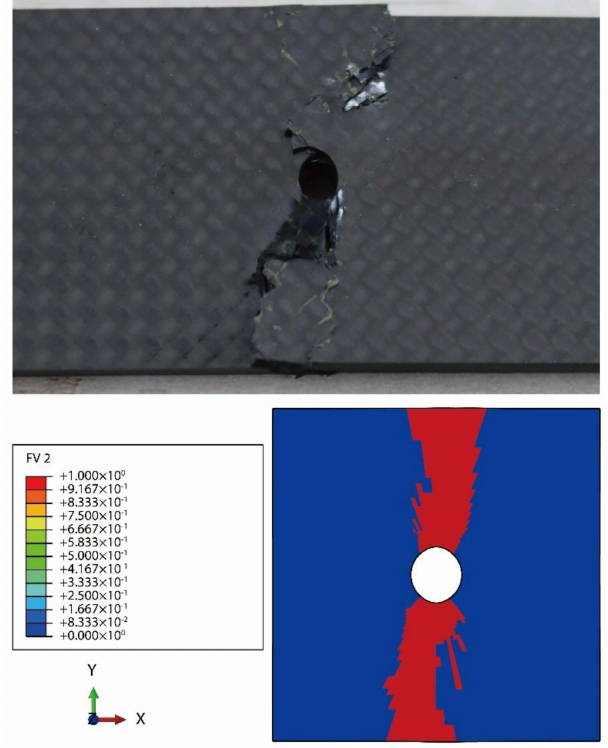
Figure 20. Comparison of the experimental and numerical failure statuses of the surface ply from the open-hole fabric